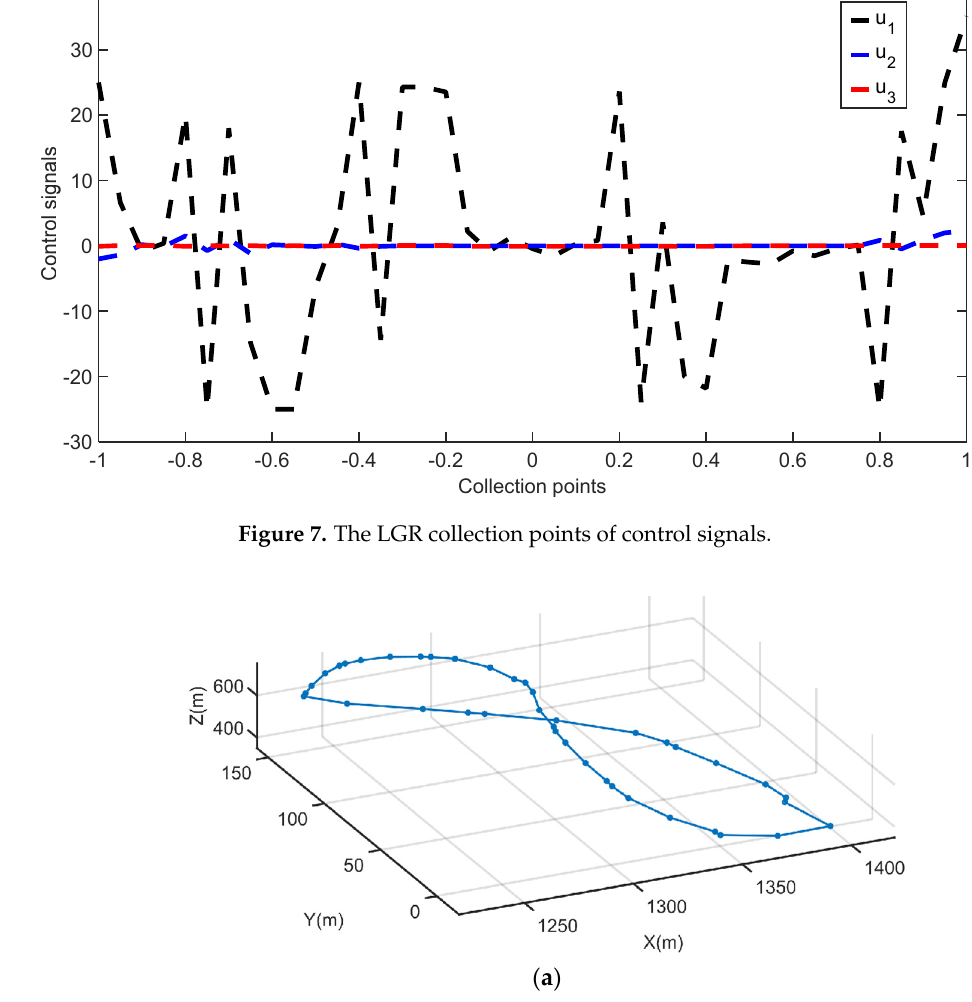
Figure 7. The LGR collection points of control signals.